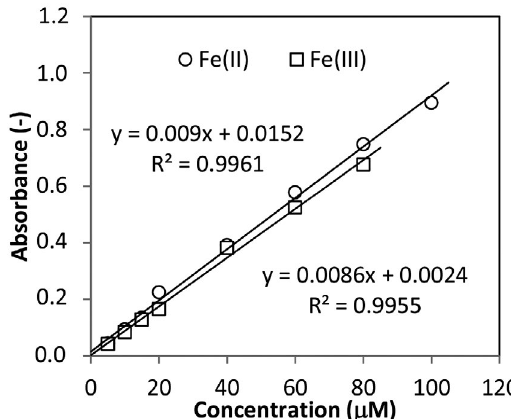
Figure 3. Calibration curves for Fe(II) and Fe(III) determination by UV-VIS spectrophotometry